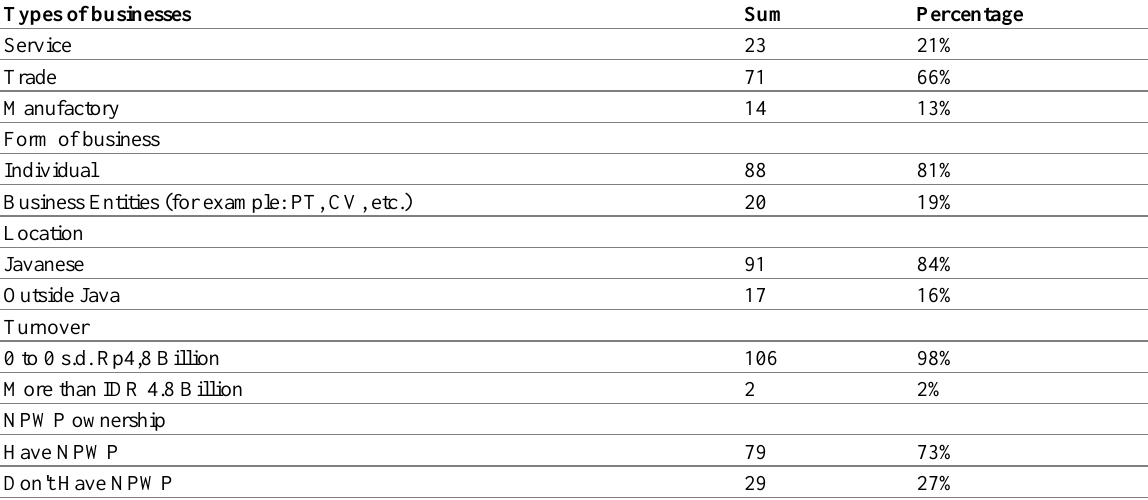
Table 2: business profiles of